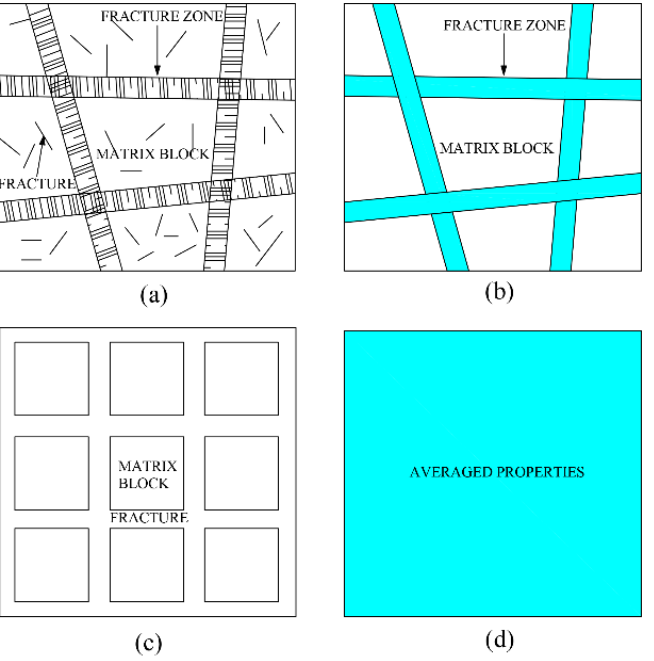
Figure 4. ( a ) Fractured porous media, ( b ) non-homogeneous representation, ( c ) dual porosity representation and ( d ) equivalent continuum representation [51].